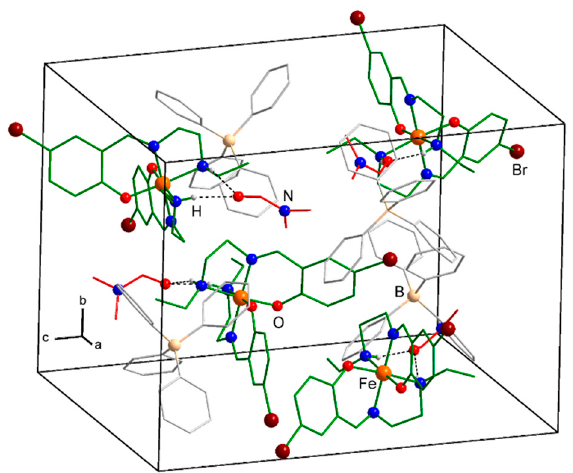
Figure 1. The unit cell of [Fe(5-Br-salEen) 2 ]BPh 4 ⸱ DMF ( 1 ) in the LS state. Cationic complex (green) and DMF (red) moieties are highlighted. Hydrogen atoms are omitted for clarity except those involved in internuclear interactions (black dotted). Carbon atoms are represented in the wireframe model. Color code: H—light grey, B—pale pink, N—blue, O—red, Br—dark red, Fe—orange.